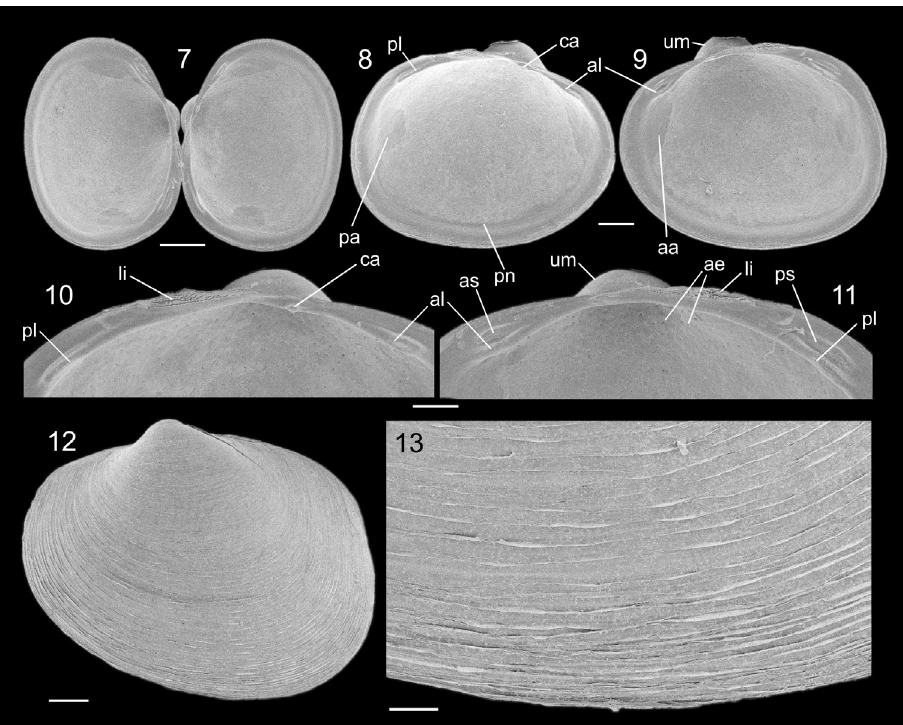
Figures 7–13. Eupera troglobia shell SEM images of paratypes 153866 7 specimen #7, both valves con- nected, opened ~120°, ventral view 8 #7, left valve, inner left view 9 #7, right valve, inner left view 10 #7, left valve, detail of hinge region, inner left view 11 #7, right valve, detail of hinge region, inner right view 12 specimen #8, left valve, outer left view 13 same, detail of surface on middle region of ventral edge. Scale bars: 500 µm ( 7, 12 ), 300 µm ( 8 ), 200 µm ( 10, 13